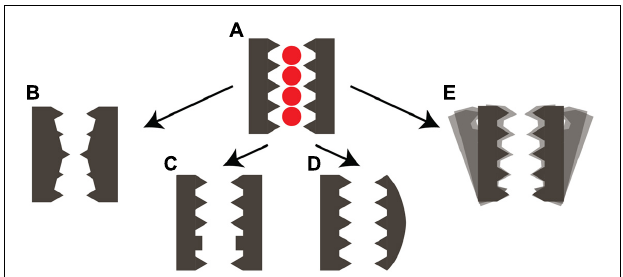
FIGURE 2 | Structural plasticity of the selectivity filter of cation channels. (A) Schematic representation of the conductive SF conformation with four ion binding sites. Arrows indicate the conversion into (B) a stable collapsed conformation as observed in KcsA (Zhou et al., 2001) or Shaker (Li et al., 2021b). (C) A carbonyl flipped conformation as observed in KcsA E71A (Cordero-Morales et al., 2006; Cheng et al., 2011) or NaK (Roy et al., 2021). (D) an asymmetric conformation as observed in NaK (Shi et al., 2018) or TREK-1 (Lolicato et al., 2020) or TASK-1 (Li et al., 2020). (E) An